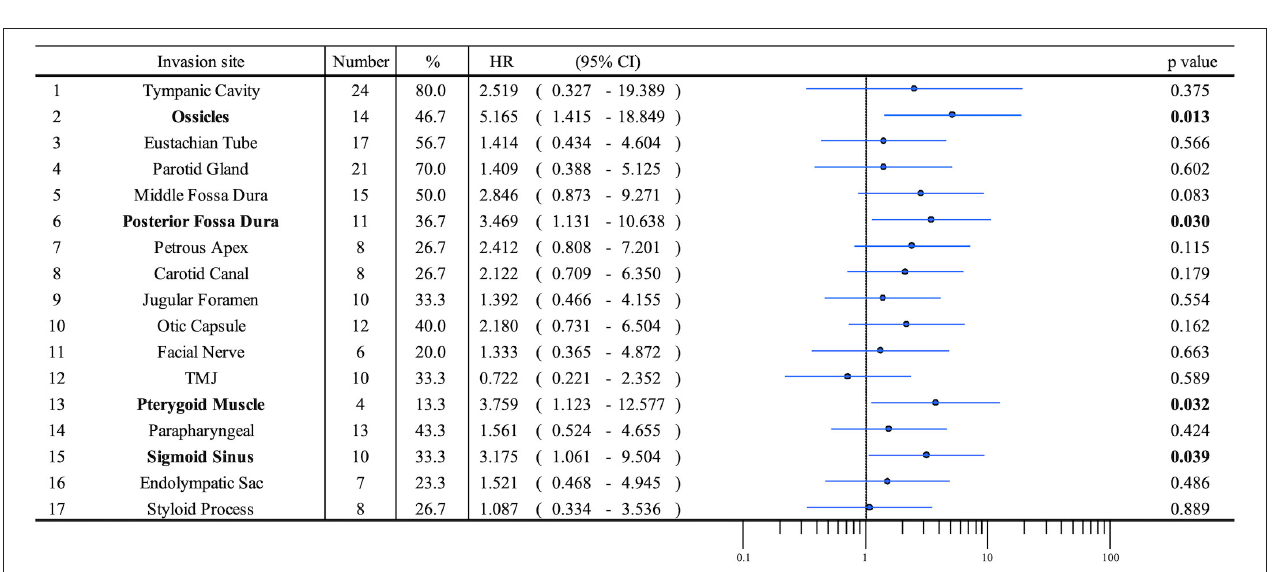
staging system that aligns with surgical procedures by more explicitly considering extension range. Other HNSCC, laryngeal, or pharyngeal carcinoma use a staging system that reflects the